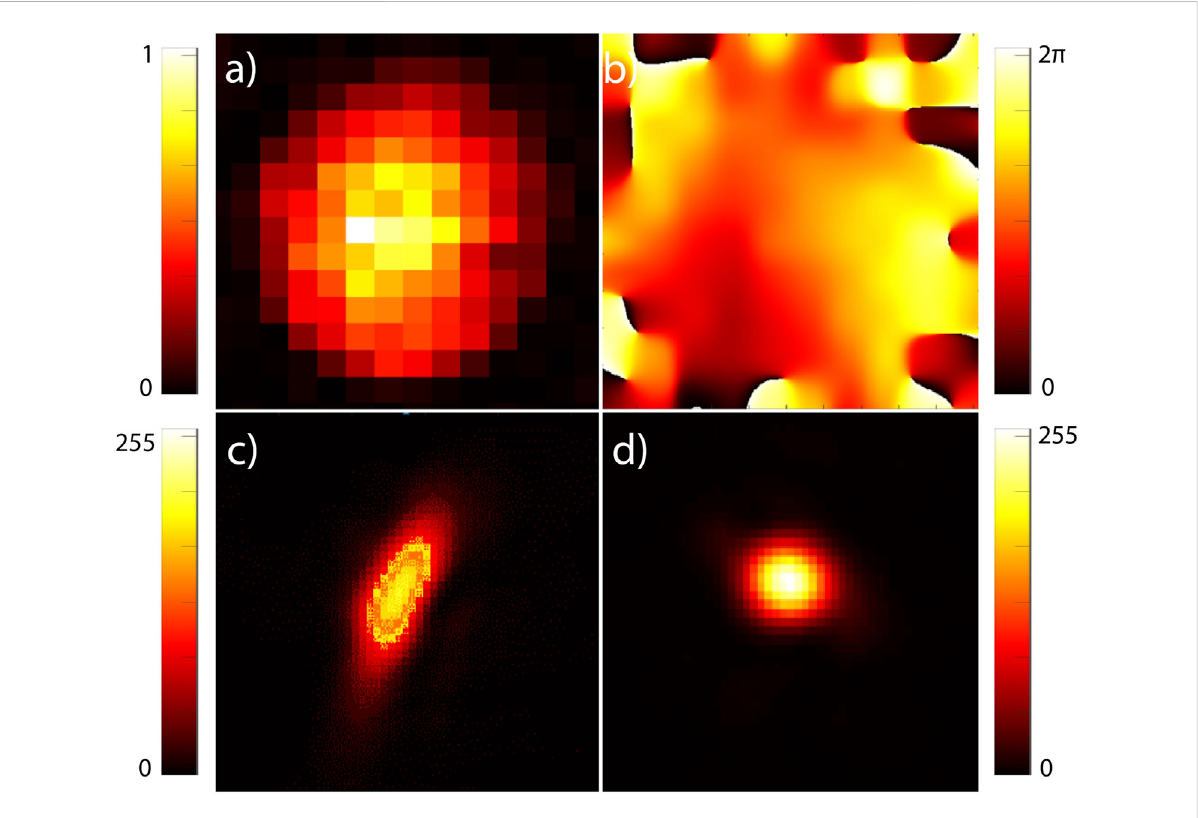
FIGURE 3 (A) Laser beam pro fi le reconstructed from the interference signal using a CCD camera situated in the conjugate plane of the spatial Light Modulator. (B) Found phase correction, as determined in-situ , described in Section 2.4. (C) Uncorrected focused beam in the imaging plane. (D) Corrected, focused beam using phase pattern in (B)